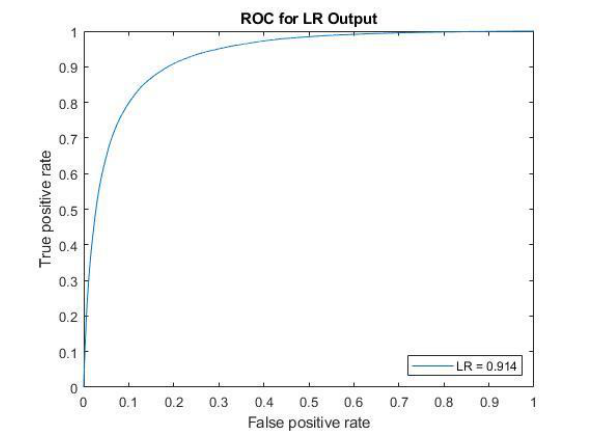
Figure 4: ROC accuracy curve of landslide susceptibility map